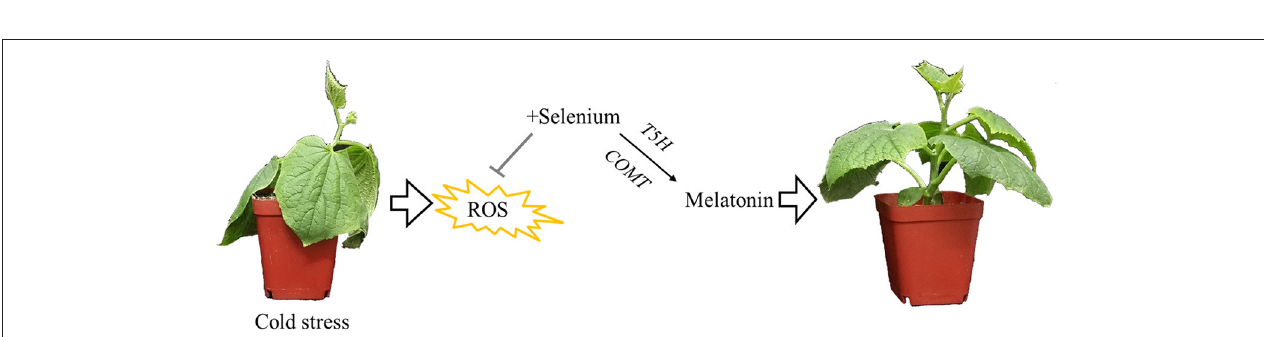
FIGURE 5 | Relative expression of melatonin biosynthesis genes in response to selenium treatment. RT-QPCR analyses was used to assess the relative expression of TDC , T5H , SNAT, and COMT in cucumber seedlings leaf of control, selenium application, cold stress, and selenium application under cold stress. Values are expressed as means of three replicates ± SD, and different letters are significantly different ( P < 0.05).